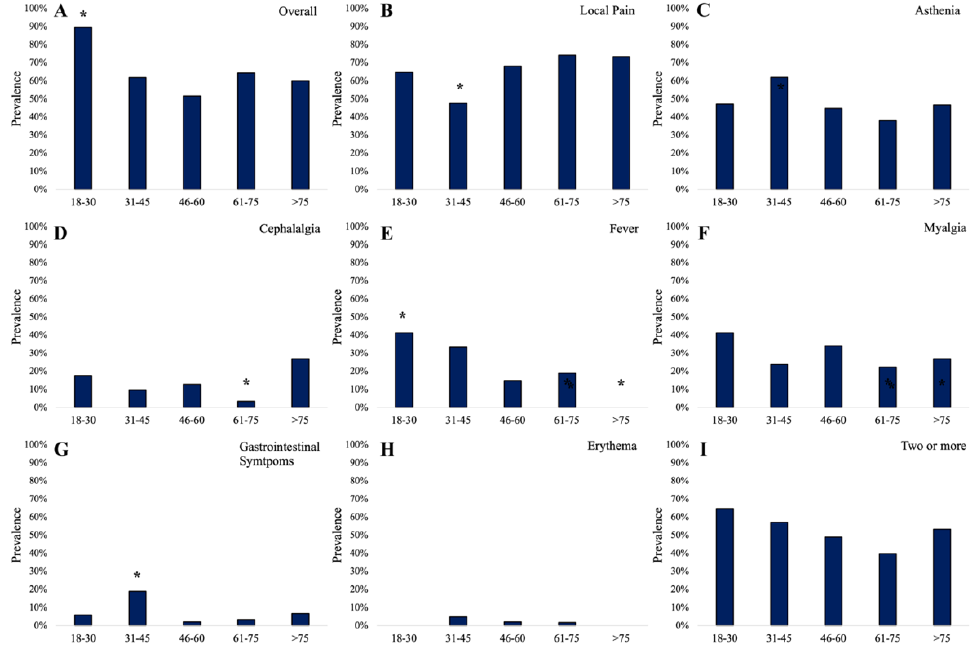
Figure 4. The overall prevalence of adverse events ( A ) and the prevalence of local pain ( B ), asthenia ( C ), cephalalgia ( D ), fever ( E ), myalgia ( F ), gastrointestinal symptoms ( G ), erythema ( H ), and the prevalence of two or more AEs ( I ) in vaccinated participants according to group of age; * statistically significant data.